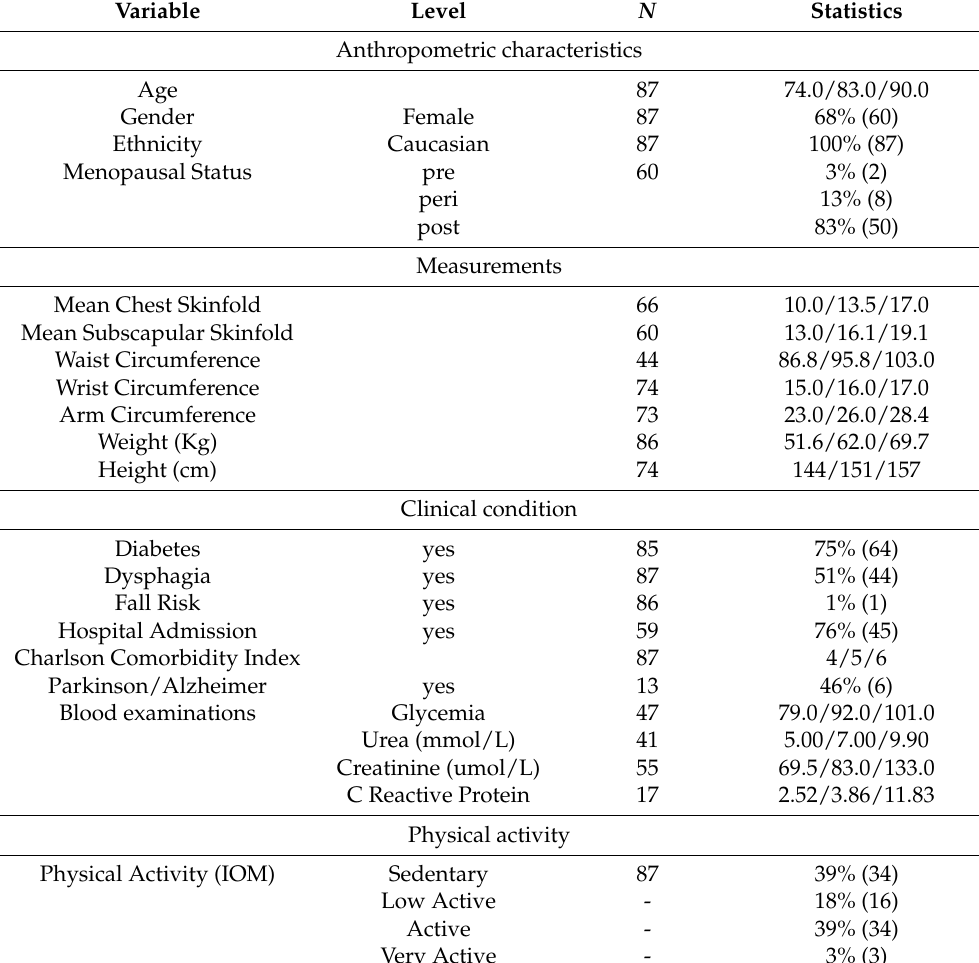
Table 3. Descriptive characteristics of the sample. Categorical data are reported as relative and absolute frequencies; continuous data as median, I, and III